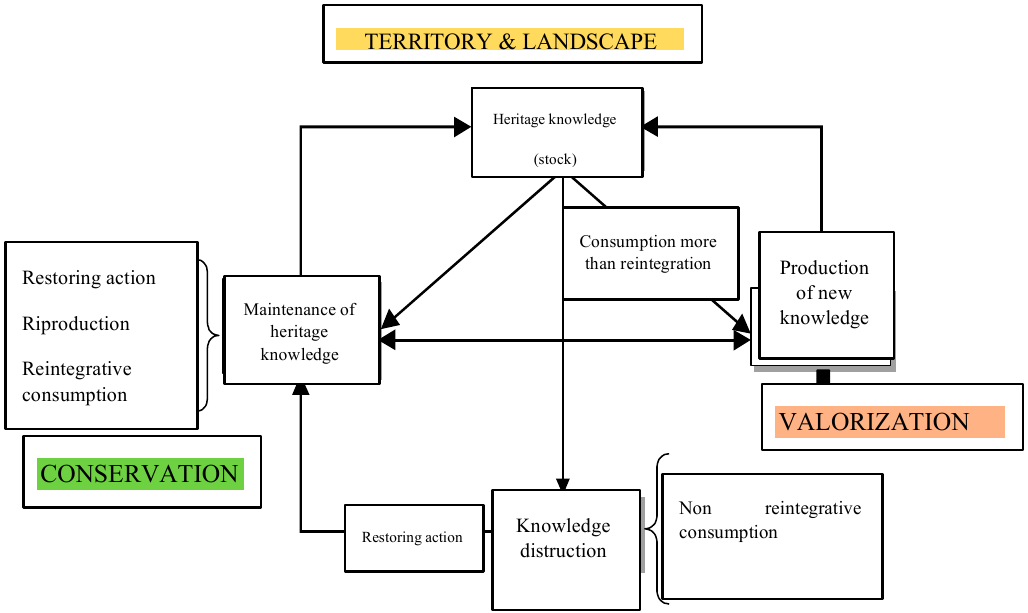
Figure 2. Art-cultural-landscape integrated system and cycle of consumption-restoring.